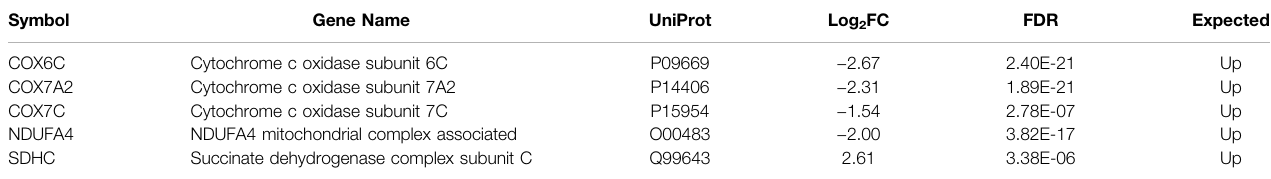
TABLE 1 | List of the fi ve altered proteins of the OXPHOS pathway in MitoPPX cells compared to Wt, identi fi ed by IPA software. ETC components showed signi fi cant differences in their expression levels (log 2 FC < 0 means decreased expression and log 2 FC > 0 means increased expression) in MitoPPX cells, compared to Wt. Alterations in these proteins allowed the IPA software to predict a decrease in the OXPHOS system. The ‘ Expected ’ column indicates the state that protein is predicted to have if the pathway were activated. FDR: False Discovery Rate.